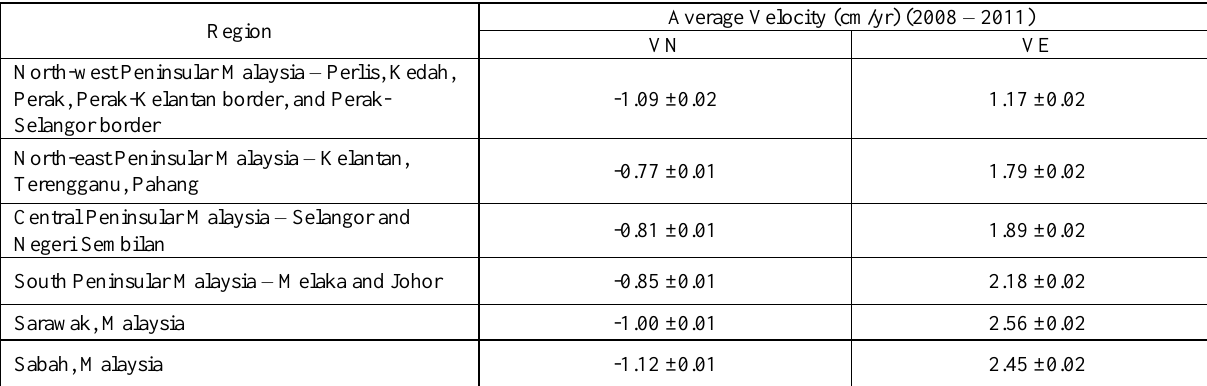
Table 5. Averaged velocities of Malaysia, categorized by area, from linear regression analysis of MyRTKnet station positions from 2008 to 2011. VN and VE represent the average north component and east component velocity, and their standard errors, respectively From table 5, between 2008 and 2011, Peninsular Malaysia moves south-east at an average velocity of -0.89 ±0.01 cm/yr for the north component, and 1.70 ±0.02 cm/yr for the east component, while East Malaysia (Sabah and Sarawak) moves south-east as well, at an average velocity of -1.06 ±0.01 cm/yr for the north component and 2.50 ±0.02 cm/yr for the east component. Both regions are moving at almost the same velocity, yet the east component of East Malaysia has a 7 mm/yr difference compared to Peninsular Malaysia. The Up component is better analysed with regard to a particular station or region; thus, only the North and East velocities are focused. Based on the findings, AMAN is the only station that exhibits a different direction with an exceptionally high velocity at 2.45 ±0.02 cm/yr north, 3.06 ±0.02 cm/yr east, and -3.35 ±0.03 cm/yr up. This is, without a doubt, due to land subsidence that occurs at the station; hence, it is removed from the average velocity results above as well as the secular deformation